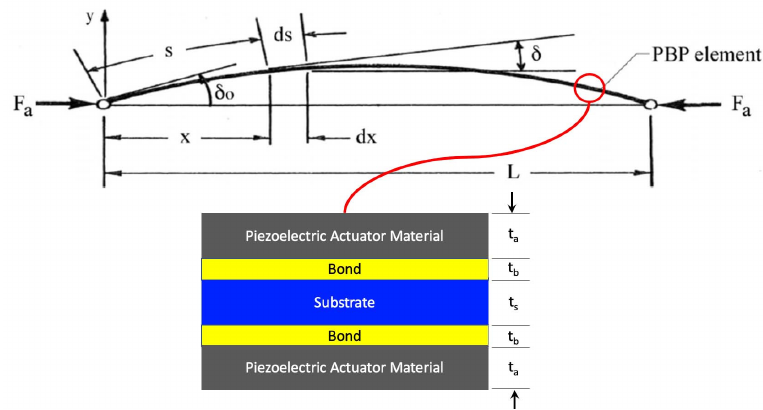
Figure 8. PBP Element Solution Conventions for Closed-Form Deflection Solution.